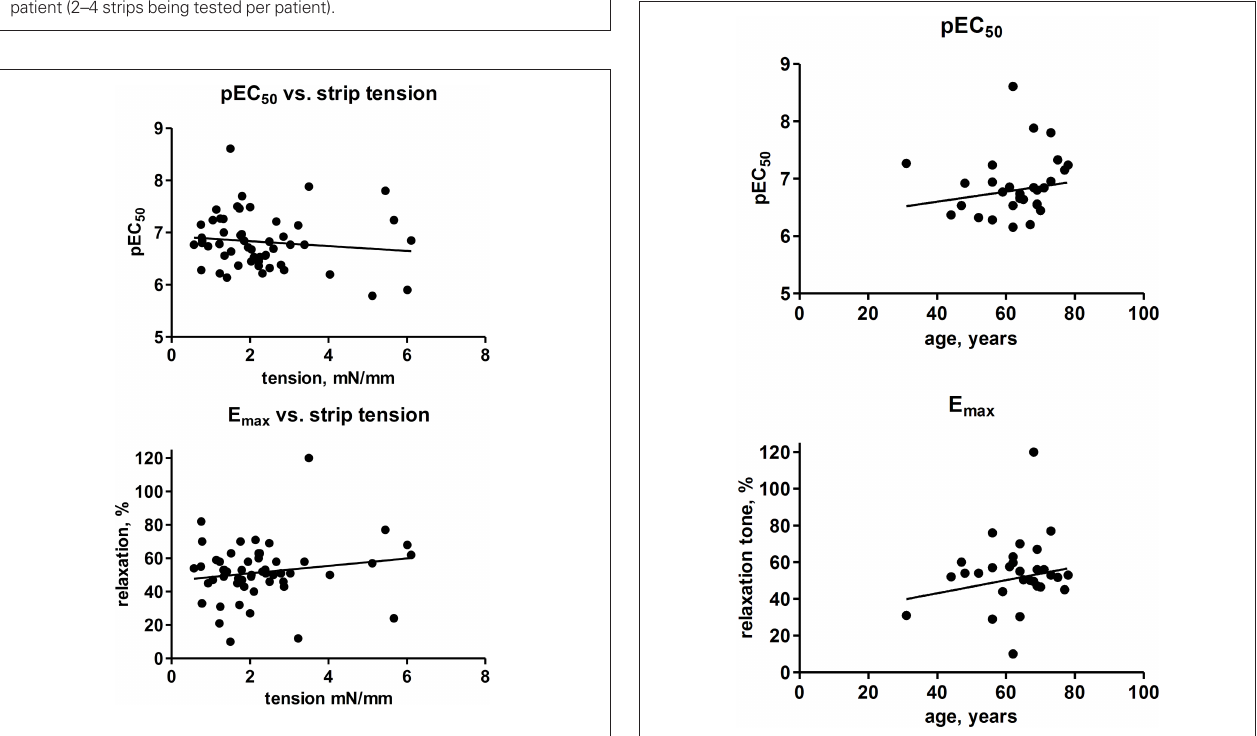
Figure 9 | effect of age on the potency and efficacy of isoprenaline to relax human detrusor strips. Each data point represents one patient (1–4 strips being tested in each of 30